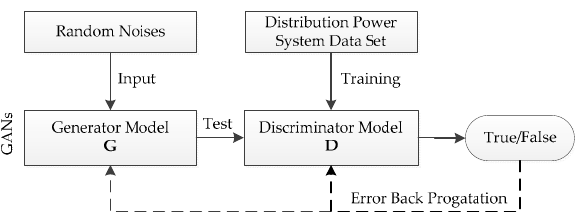
Figure 2. Diagram of generative adversarial networks (GANs) calculation Figure 2 . Diagram of generative adversarial networks (GANs) calculation processing.